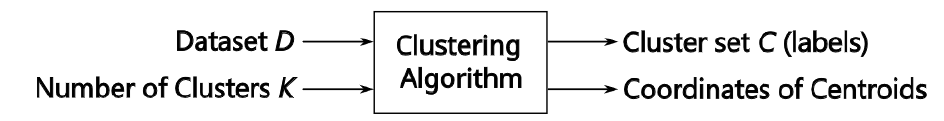
Figure 2. Diagram which illustrates the main inputs and outputs of the clustering